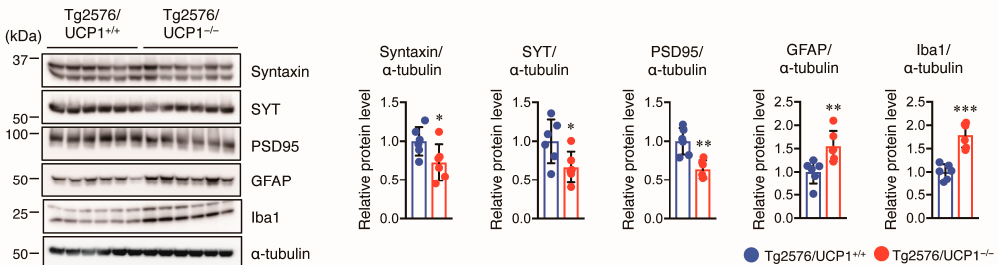
Figure 6. UCP1 deletion in Tg2576 mice enhances glial activation and decreases synaptic protein levels. Representative immunoblots showing the cortical levels of of syntaxin, SYT, PSD95, GFAP, Iba1, and α -tubulin in 17-month-old Tg2576/UCP1 +/+ and Tg2576/UCP1 -/- mice (left panel). Relative protein levels quantified by densitometry (right panels). The results shown are mean ± SD, n = 6 for each group, * p < 0.05, ** p < 0.01, *** p < 0.001 vs. Tg2576/UCP1 +/+ , as determined by Student’s t -test.